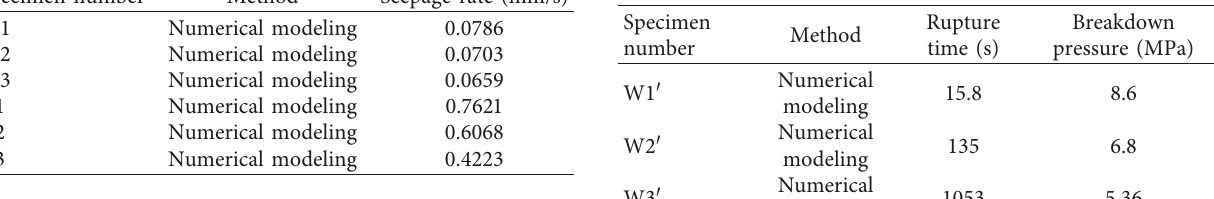
Figure 15: Plots of the seepage range with time during fracturing (I). (a) Water fracturing. (b) Nitrogen gas fracturing. Table 7: Results of seepage rate (I). Table 8: The numerical results of rupture time and breakdown pressure with the water fracturing.